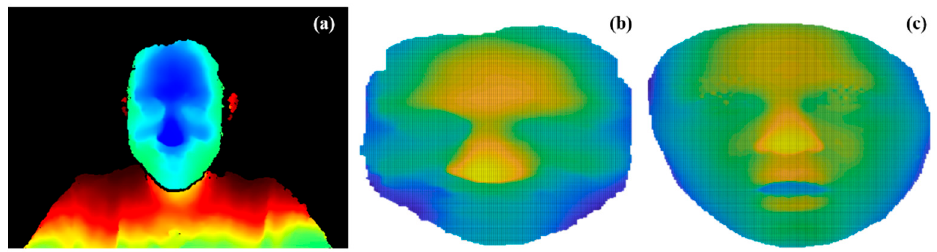
Figure 1. Depth map in output from the 3D sensor ( a ), the same data elaborated in MatLab ( b ), and the shell of a Bosphorus DB image ( c ).